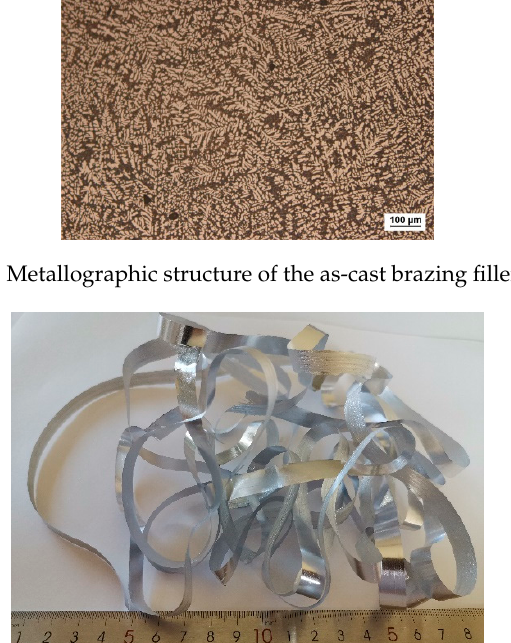
Figure 3. Foil-like brazing material fabricated by melt-spinning technology.